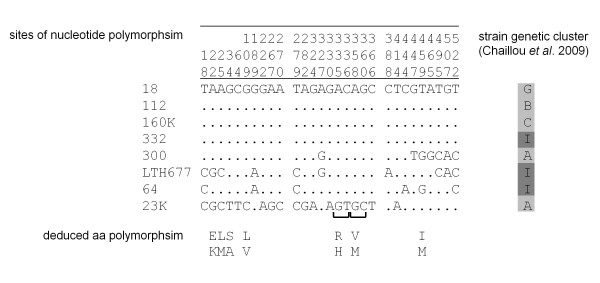
Polymorphic nucleotide sites of sigH sequences in L. sakei. The entire CDS sequence (561 nt) was analyzed with MEGA software http://www.megasoftware.net/. Only nucleotide residues different from the upper line sequence are written. The site numbers at the top are in vertical format. Letter-code genetic cluster according to Chaillou et al. [20] is indicated for each strain and reported subspecies are shaded differently. Polymorphic deduced aa are indicated under the sequence.